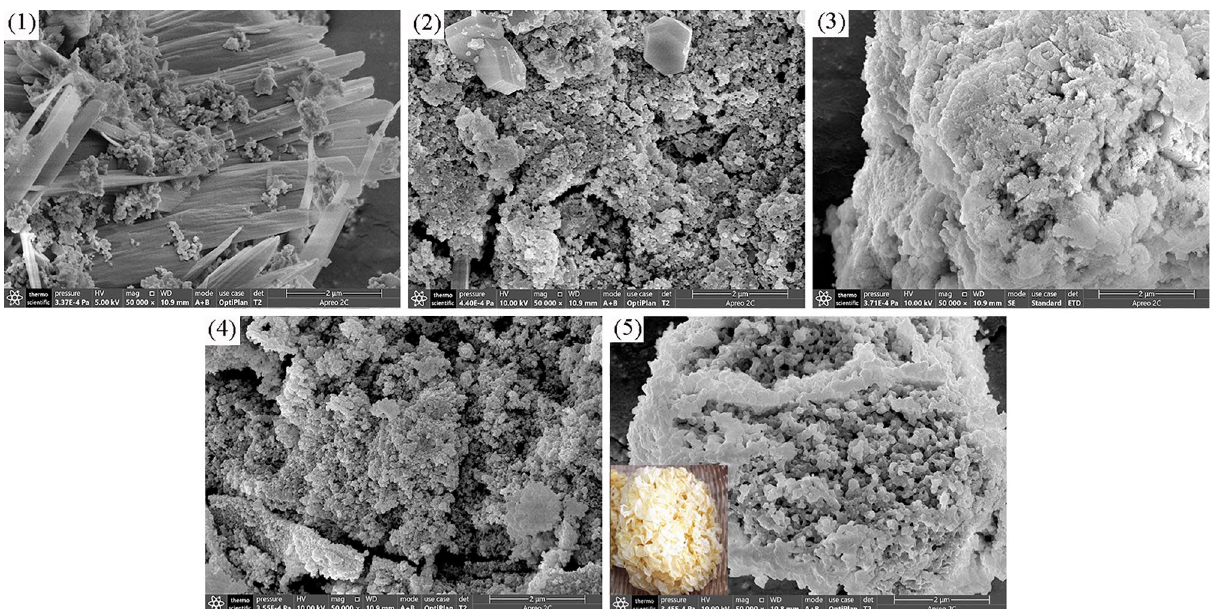
Figure 5. SEM images of cerium manganese catalysts: (1) CM-Na; (2) CM-NaC; (3) CM-NC; (4) CM-N; (5) CM-3.